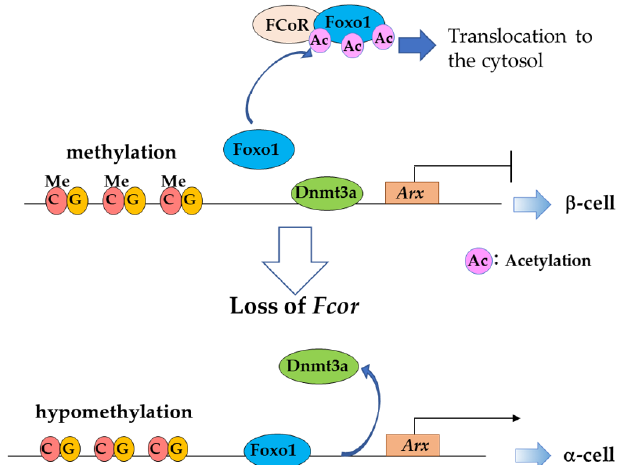
Figure 9. Arx expression is regulated by FCoR and Foxo1 interaction via methylation. FCoR suppresses Foxo1 binding to DNA and induces the binding of Dnmt3a to the promoter region of Arx, leading to methylation in the CG-rich region and suppression of Arx expression. In the absence of FcoR, Foxo1 binds to the promoter region and releases Dnmt3a, leading to hypomethylation of the CG-rich region and Arx expression induction.